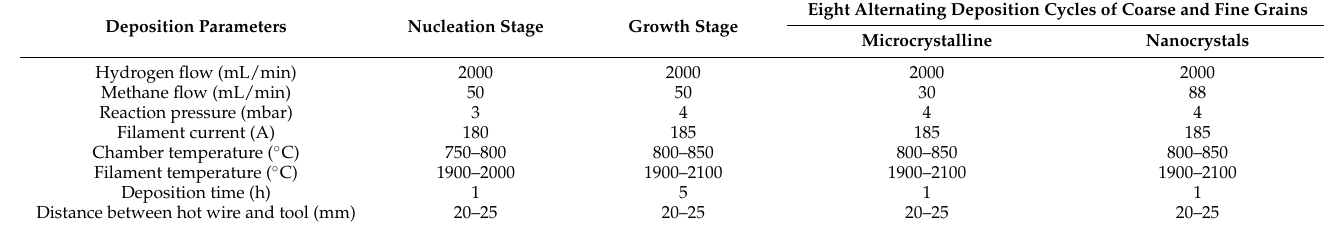
Table 3. CVD coating deposition process parameters.